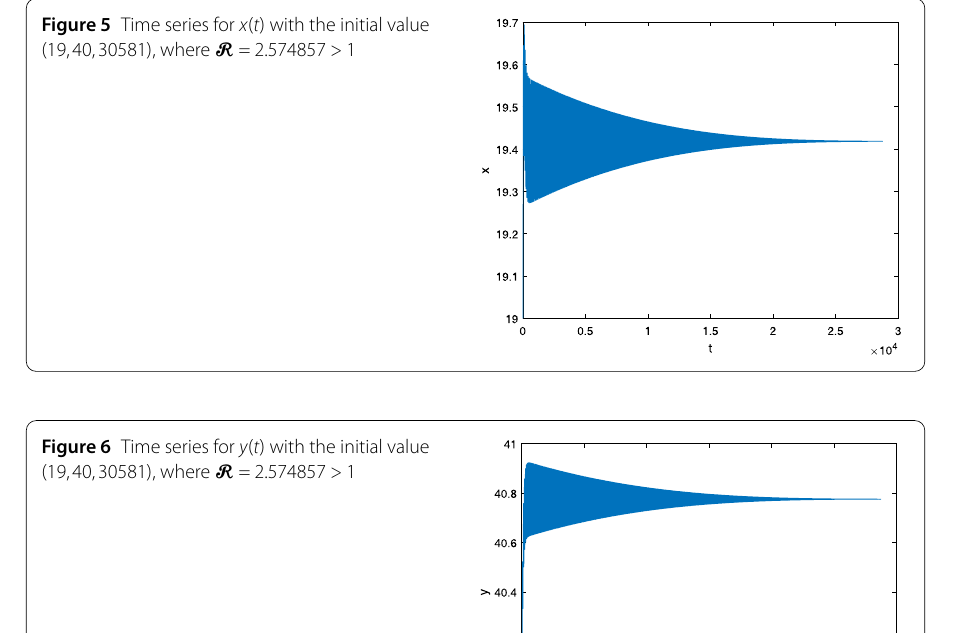
Figure 6 Time series for y ( t ) with the initial value (19,40,30581), where R = 2.574857 > 1